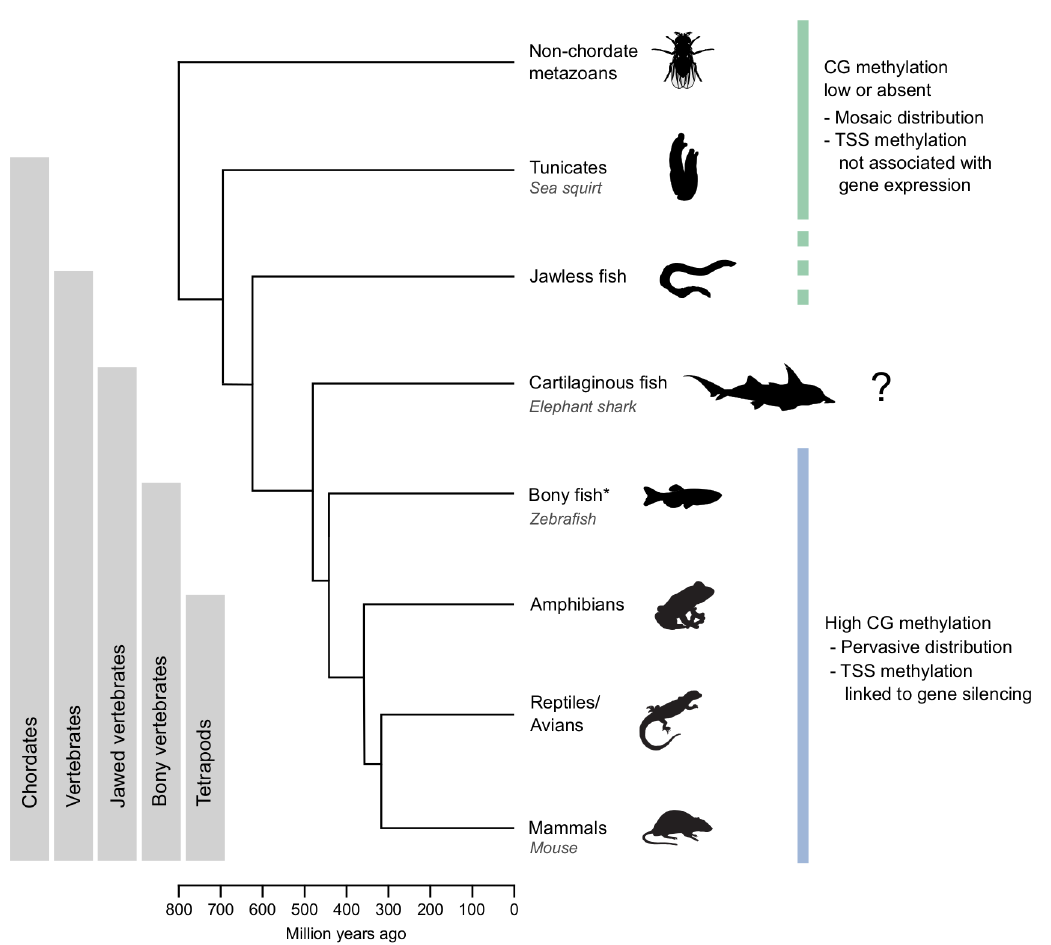
Figure 1. Phylogenetic tree showing major vertebrate groups, invertebrate outgroups and defining characteristics of their methylomes. The genomes of higher vertebrates are pervasively hypermethylated, with the exception of regulatory elements such as transcription start sites (TSSs), where the presence of methylation is associated with gene silencing (blue line). In contrast, invertebrate genomes are generally sparsely methylated in a mosaic pattern, and lack the inverse relationship between TSS methylation and expression that characterises vertebrates (green line). Certain invertebrate species appear to lack methylation altogether. Due to a paucity of data from basal vertebrate species, the evolutionary history of the CG methylation system present in higher vertebrates is unclear. Preprint methylation data from the sea lamprey Petromyzon marinus is not indicated here (see discussion). The names of organisms examined in this study are noted underneath the appropriate class. * The lobe-finned fish (sarcopterygii), as well as the cephalochordata (a basal chordate taxon), have been omitted for clarity. The following terms have been treated as equivalent: jawless fish and cyclostomata, jawed vertebrates and gnathostomata, cartilaginous fish and chondrichthyes, bony vertebrates and euteleostomi. Median divergence times from the TimeTree database 43 were used to construct the